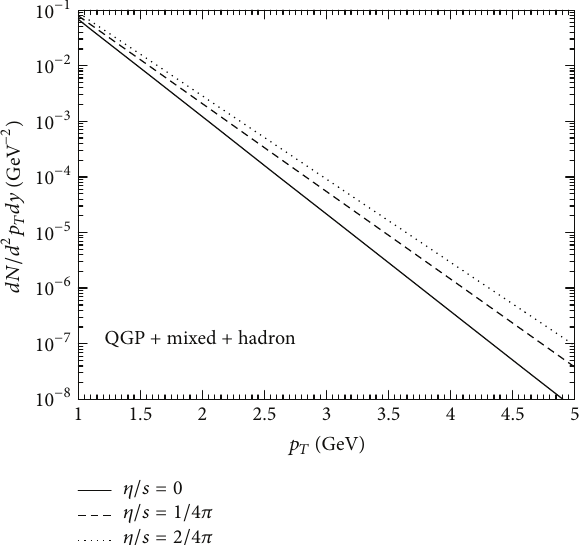
Figure 12: Transverse momentum distribution of thermal photons from QGP for various values of 𝜂/𝑠 in the scenario (ii).